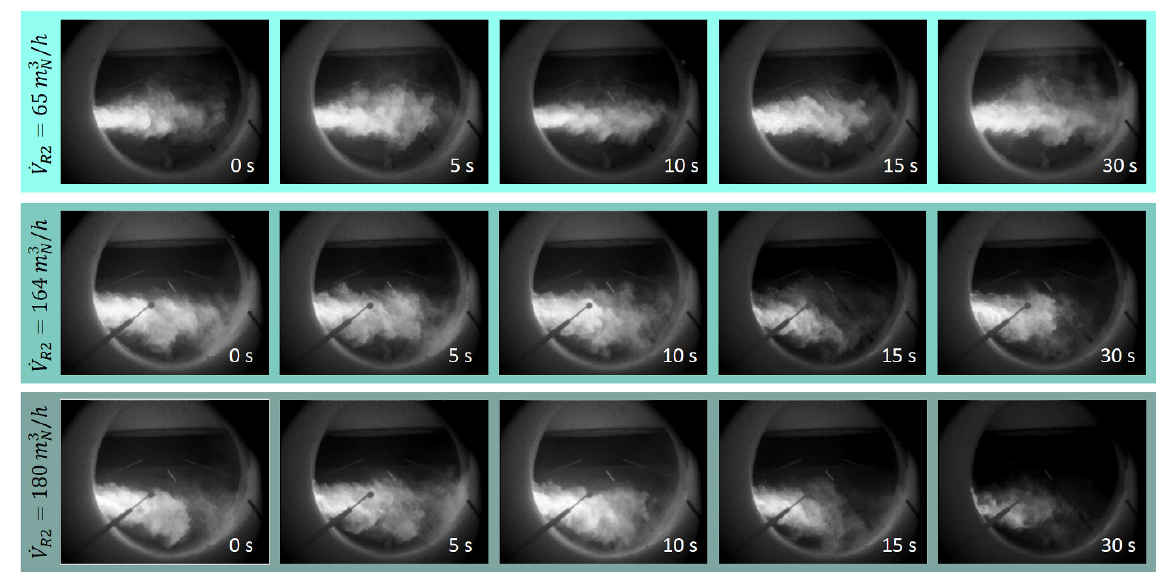
Figure 11. Photo series of a non-oscillating flame at different air flows in R2. The two lower photo series at a volume flow in R2 of 164 and 180 m N3 /h show a higher flame brightness in the area near the flame root than in the burnout area of the flame. Here the volume flow of combustion air is significantly reduced (cf. Table 3), which leads to a shorter and bushier flame.